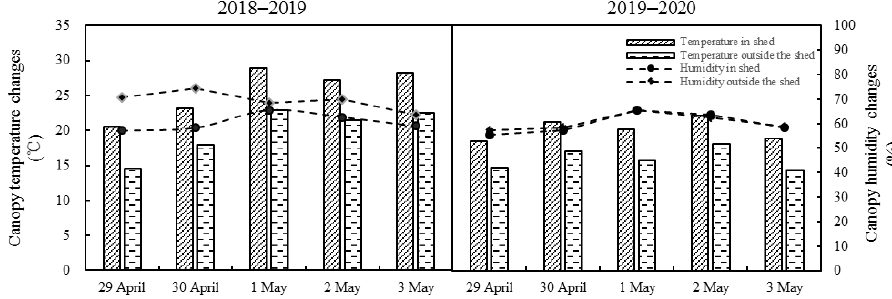
Figure 2. The temperature and humidity changes in the canopy during the treatment.